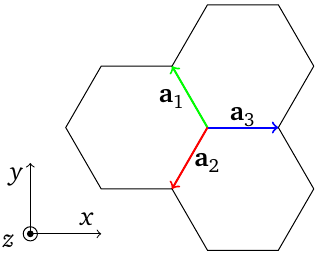
Figure 1: The honeycomb lattice with three different types of bonds and our choice of the global coordinate